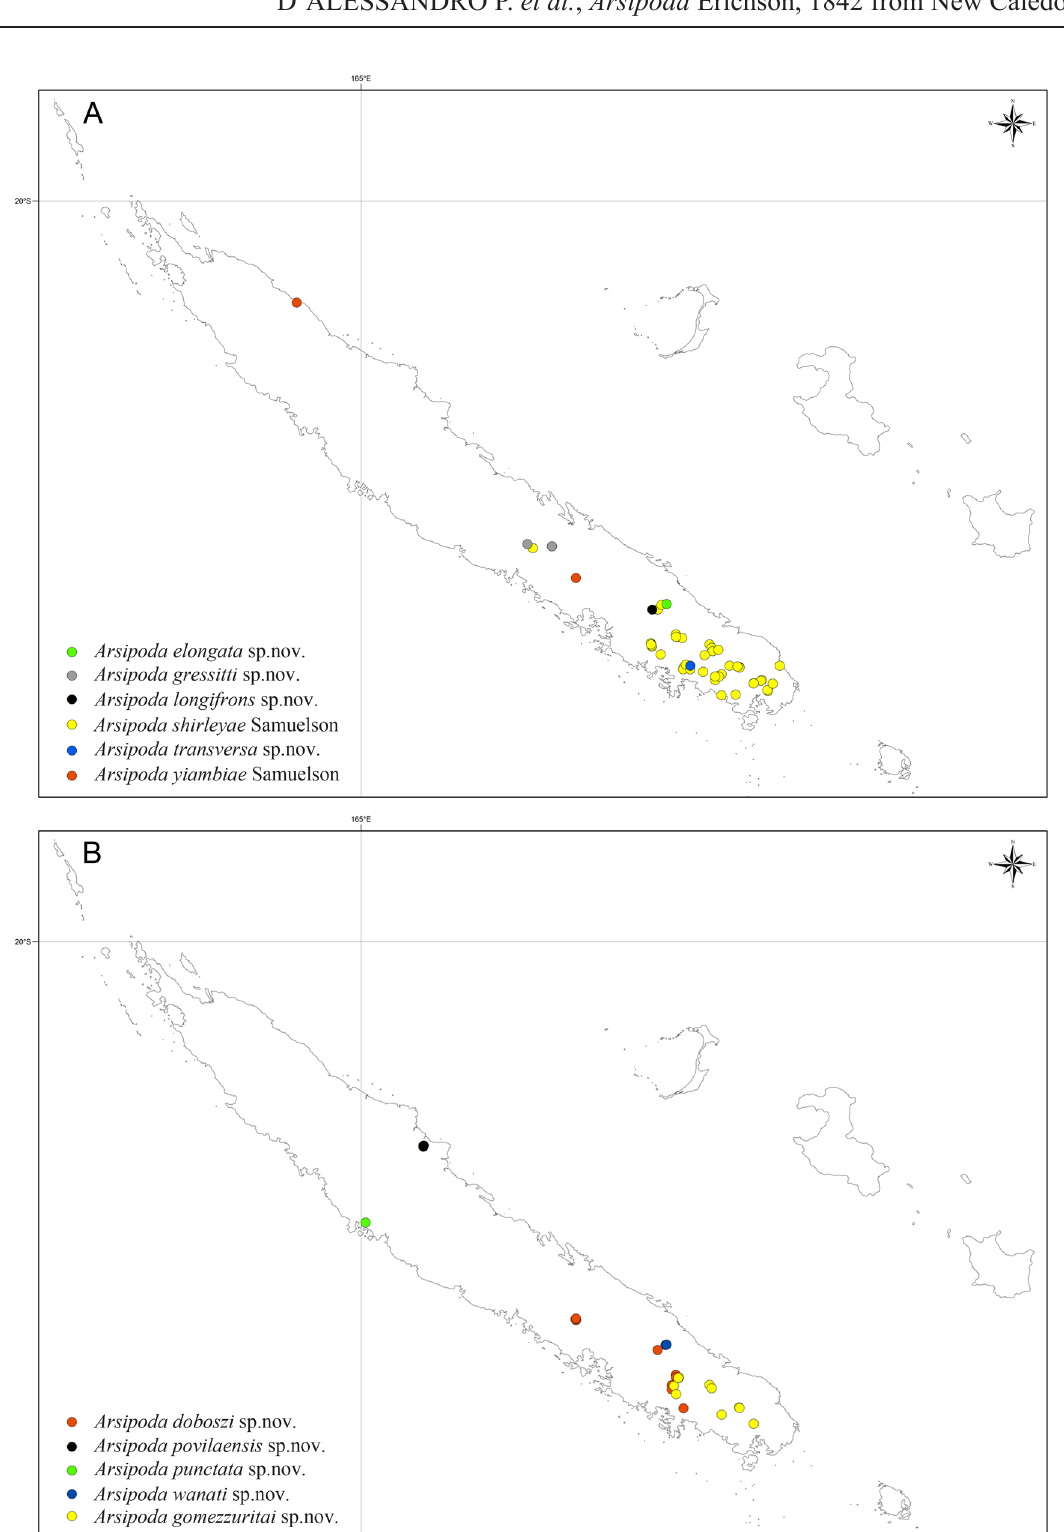
Fig. 15. Distributions of New Caledonian Arsipoda . A . Arsipoda elongata sp. nov., A. gressitti sp.